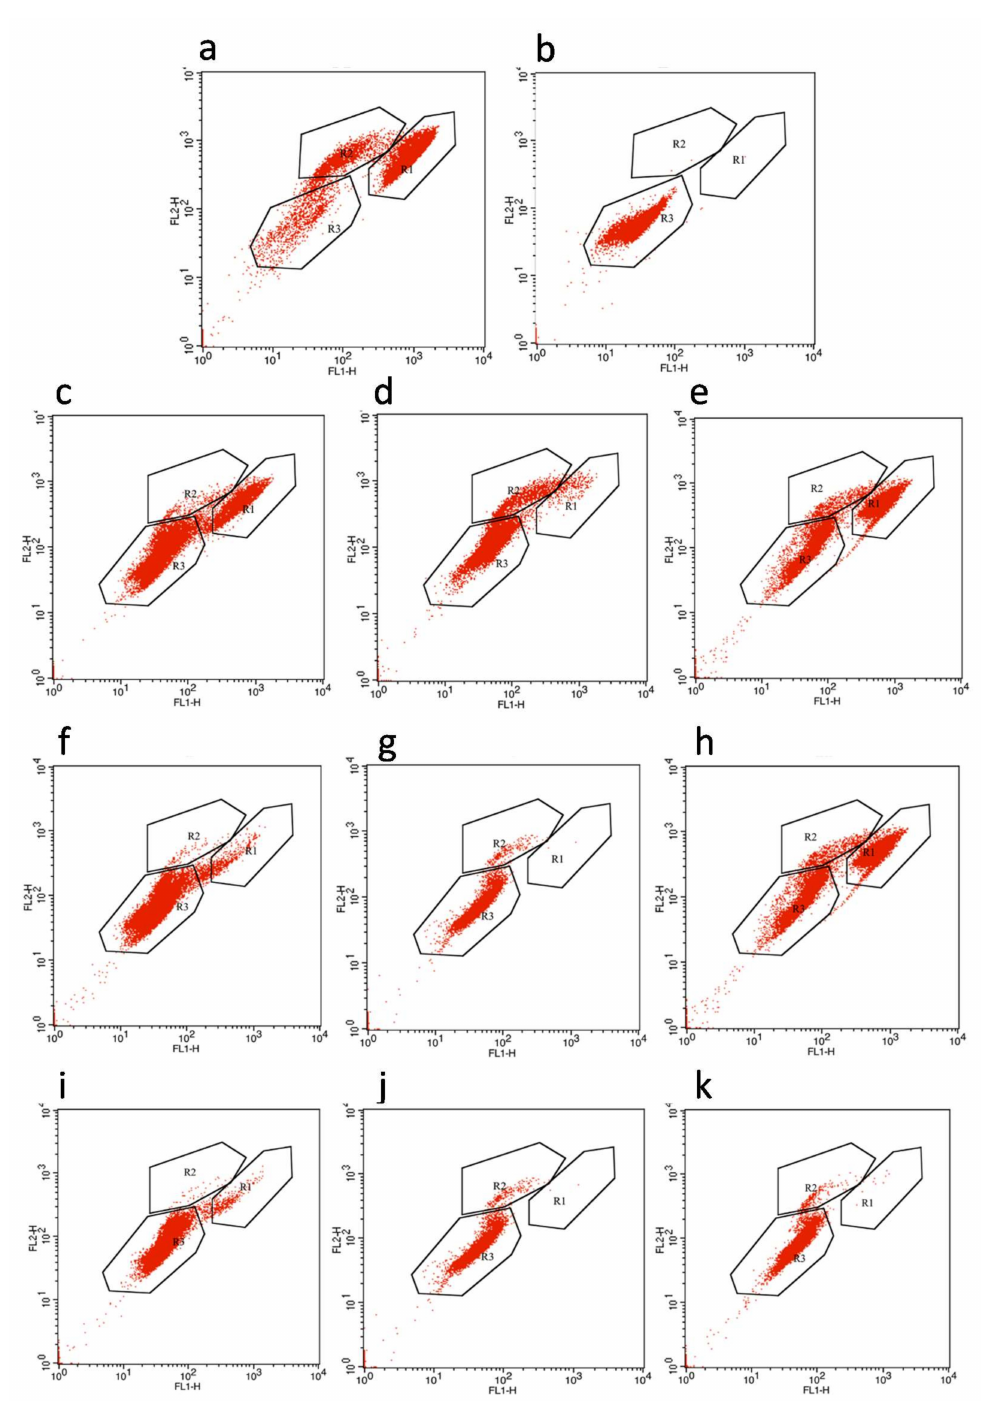
Figure 4. Flow cytometric analysis of E. coli di ff erently packaged before and after di ff erent pressure treatments. Negative ( a ) and positive ( b ) E. coli cells; Vacuum-packed ( c ), CO 2 -packed ( d ), and N 2 -packed ( e ) E. coli cells after HHP treatment at 250 MPa: Vacuum-packed ( f ), CO 2 -packed ( g ), and N 2 -packed ( h ) E. coli cells after HHP treatment at 350 MPa; Vacuum-packed E. coli cells ( i ), CO 2 -packed ( j ) and N 2 -packed ( k ) E. coli cells after HHP treatment at 450